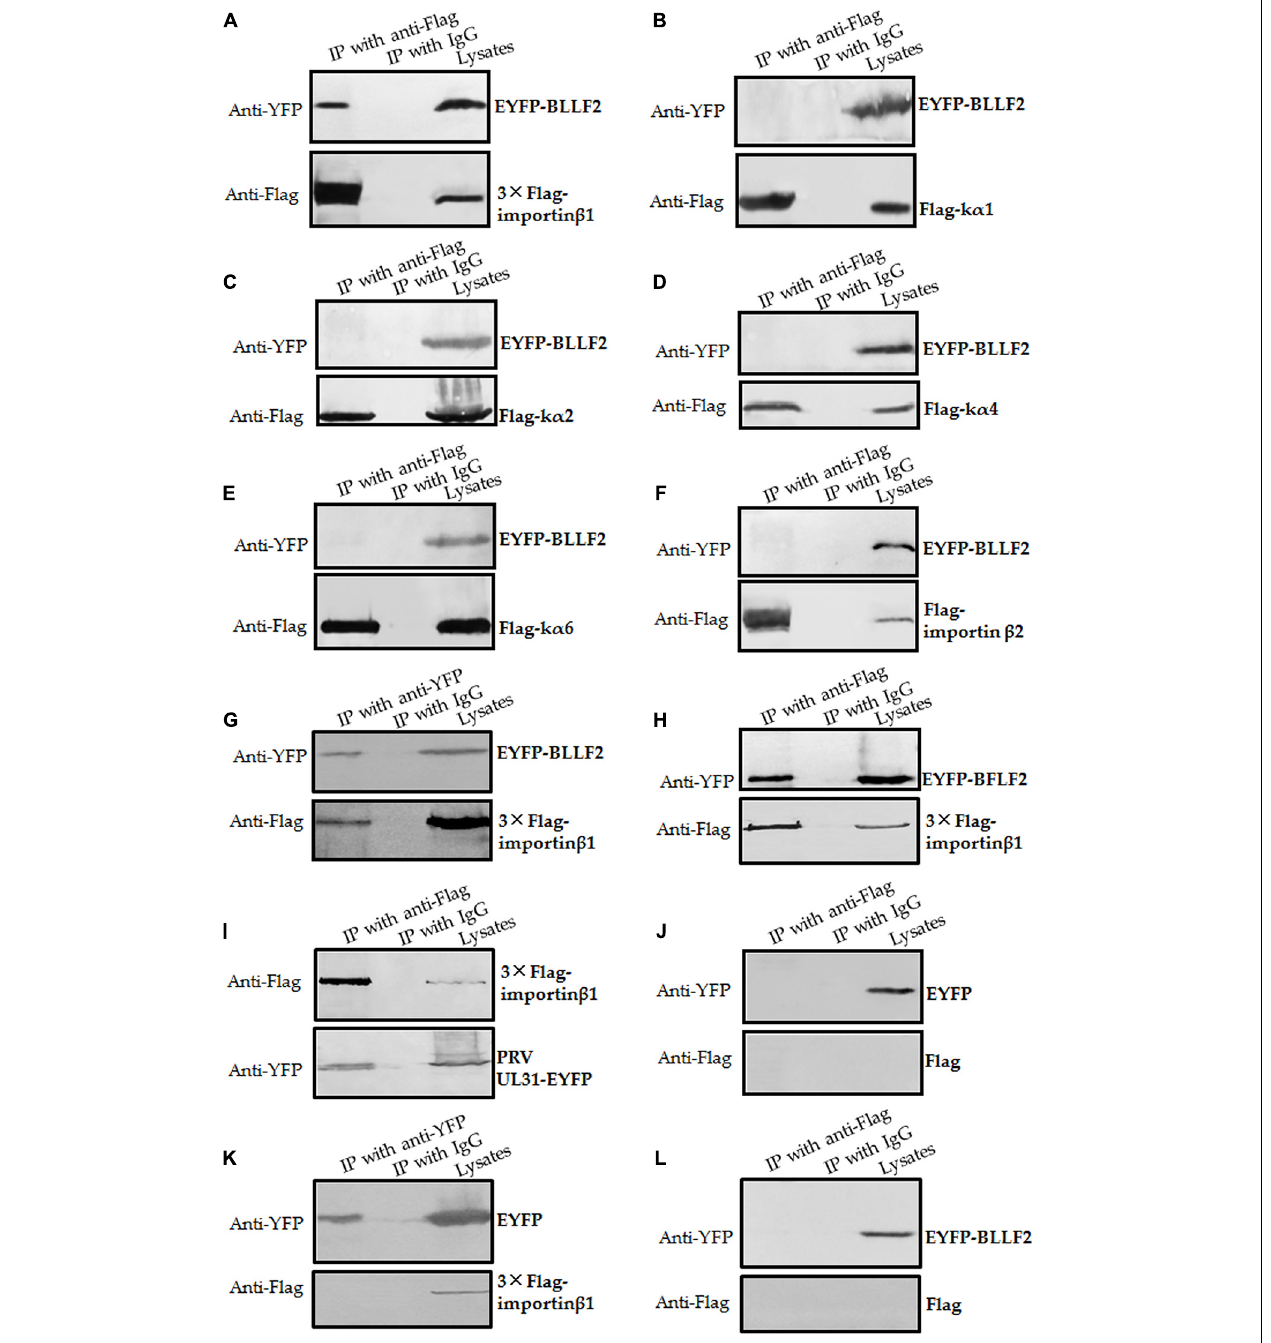
FIGURE 6 | BLLF2 binds to importin β 1. (A–G,L) Co-IP analysis of BLLF2 with importin β 1 (A,G) , importin α 5 (k α 1) (B) , importin α 1 (k α 2) (C) , importin α 3 (k α 4) (D) , importin α 7 (k α 6) (E) , importin β 2 (F) , or Flag vector (L) . HEK293T cells were co-transected with expression plasmids combination of 3 × Flag-importin β 1/EYFP-BLLF2 (A,G) , Flag-k α 1/EYFP-BLLF2 (B) , Flag-k α 2/EYFP-BLLF2 (C) , Flag-k α 4/EYFP-BLLF2 (D) , Flag-k α 6/EYFP-BLLF2 (E) , Flag-importin β 2/EYFP-BLLF2 (F) , or Flag vector/EYFP-BLLF2 (L) for 24 h; cells were subsequently lysed and Co-IPed with anti-Flag mAb (A–F,L) or anti-YFP pAb (G) or control IgG, and then WB analysis was carried out with the indicated Abs. (H,I) Co-IP analysis of importin β 1 with BFLF2 (H) or PRV UL31 (I) . HEK293T cells were co-transected with expression plasmids combination of 3 × Flag-importin β 1/EYFP-BFLF2 (H) or 3 × Flag-importin β 1/PRV UL31-EYFP (I) for 24 h, and cells were then lysed and Co-IPed with anti-Flag mAb or control IgG, and then WB analysis was carried out with the indicated Abs. (J,K) Co-IP analysis of EYFP vector with Flag vector (J) or importin β 1 (K) . HEK293T cells were co-transected with expression plasmids combination of Flag vector/EYFP vector (J) or 3 × Flag-importin β 1/EYFP vector (K) for 24 h; cells were then lysed and Co-IPed with anti-Flag mAb (J) or anti-YFP (K) or control IgG, and then WB analysis was carried out with the indicated Abs.